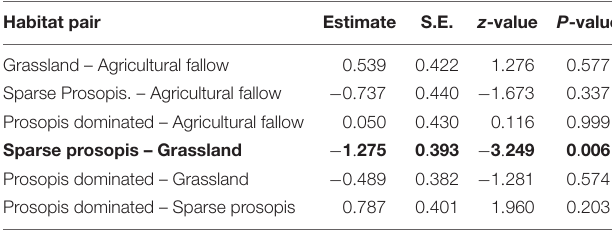
TABLE 3 | Results of Tukey- pairwise comparisons for variation in log-transformed rodent abundance. The estimates are differences between means of two groups along with associated standard error (S.E.), Z statistic, and p -value.